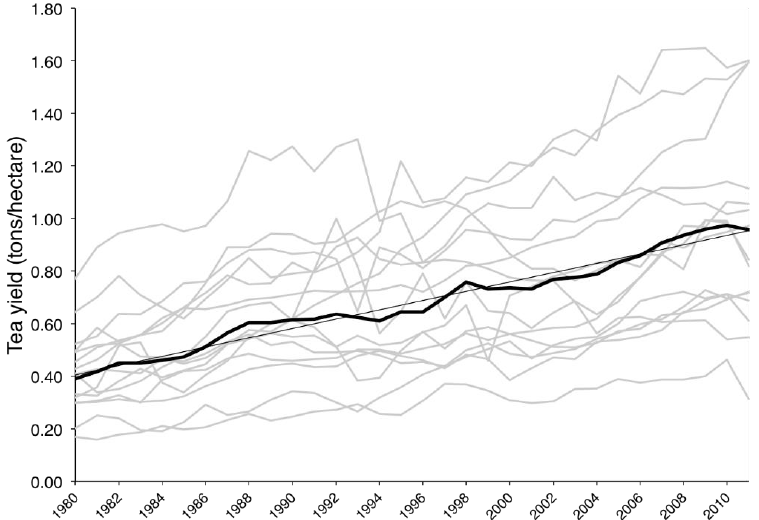
Figure 3. Tea yield (tons/hectare) over time across China’s tea producing provinces. The grey lines represent the yield trend over time for each of the 15 provinces and the black line is the mean yield across all provinces.